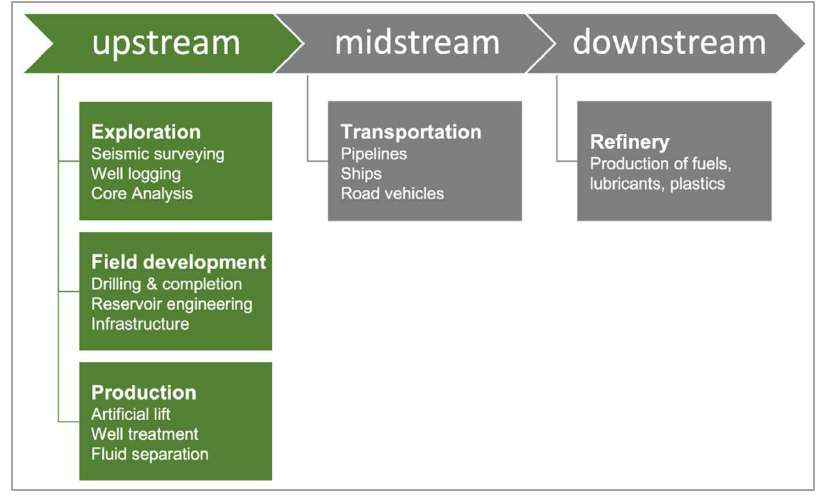
Figure 4. Upstream sector of the oil and gas industry